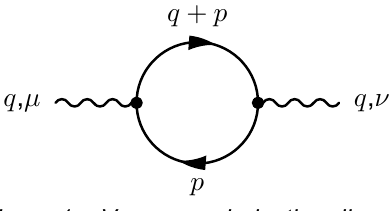
Figure 1 – Vacuum polarisation diagram Рис. 1 − Диаграмма поляризации вакуума Слика 1 – Дијаграм поларизације